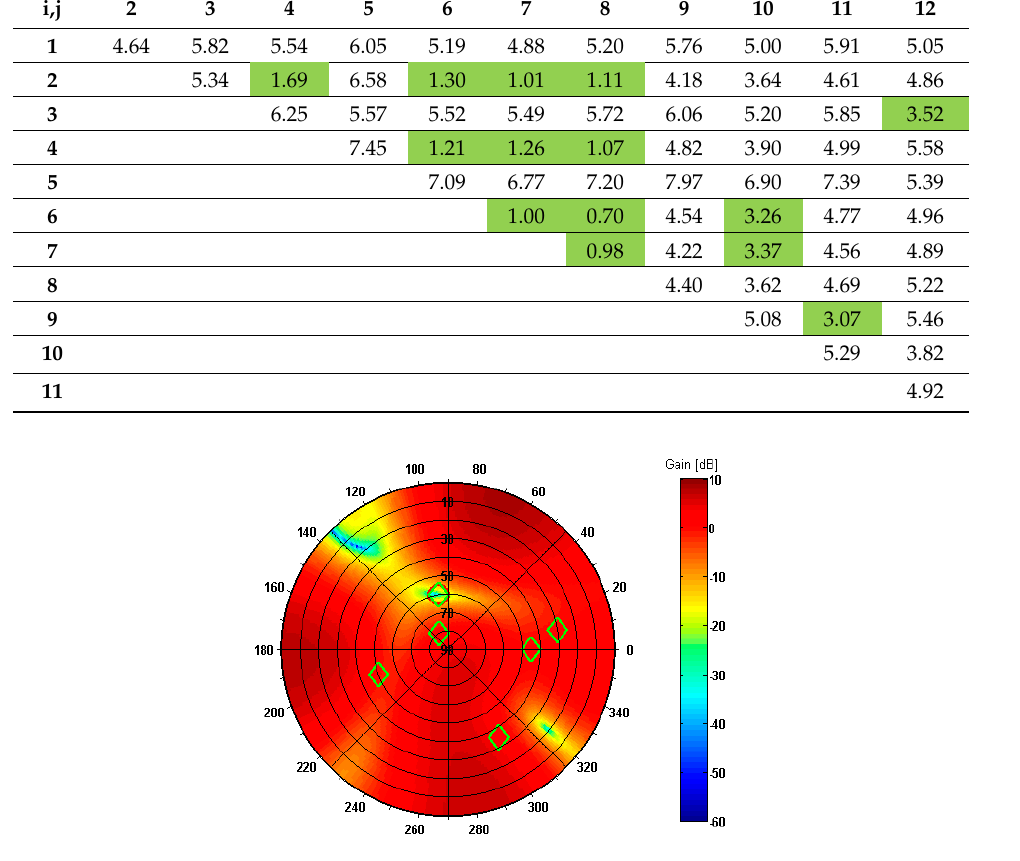
Figure 11. Reception pattern of antenna array in spoofing scenario 2.